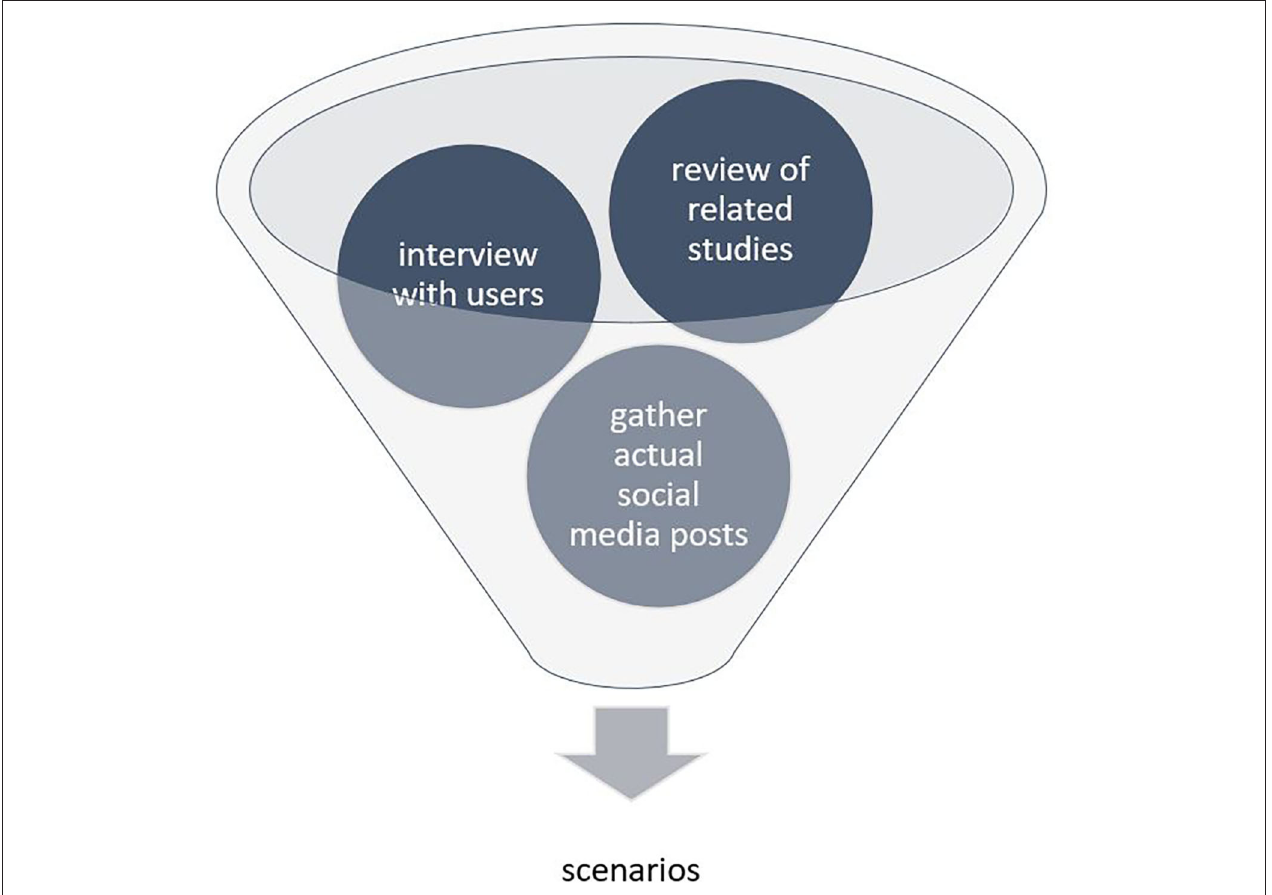
FIGURE 1 | Scenario